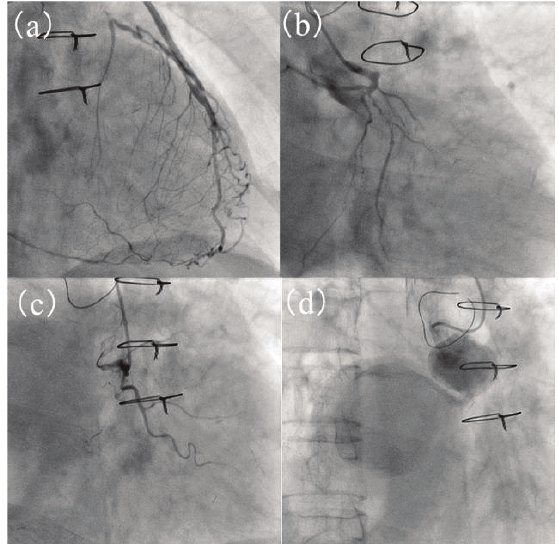
Figure 3: Coronary angiography.